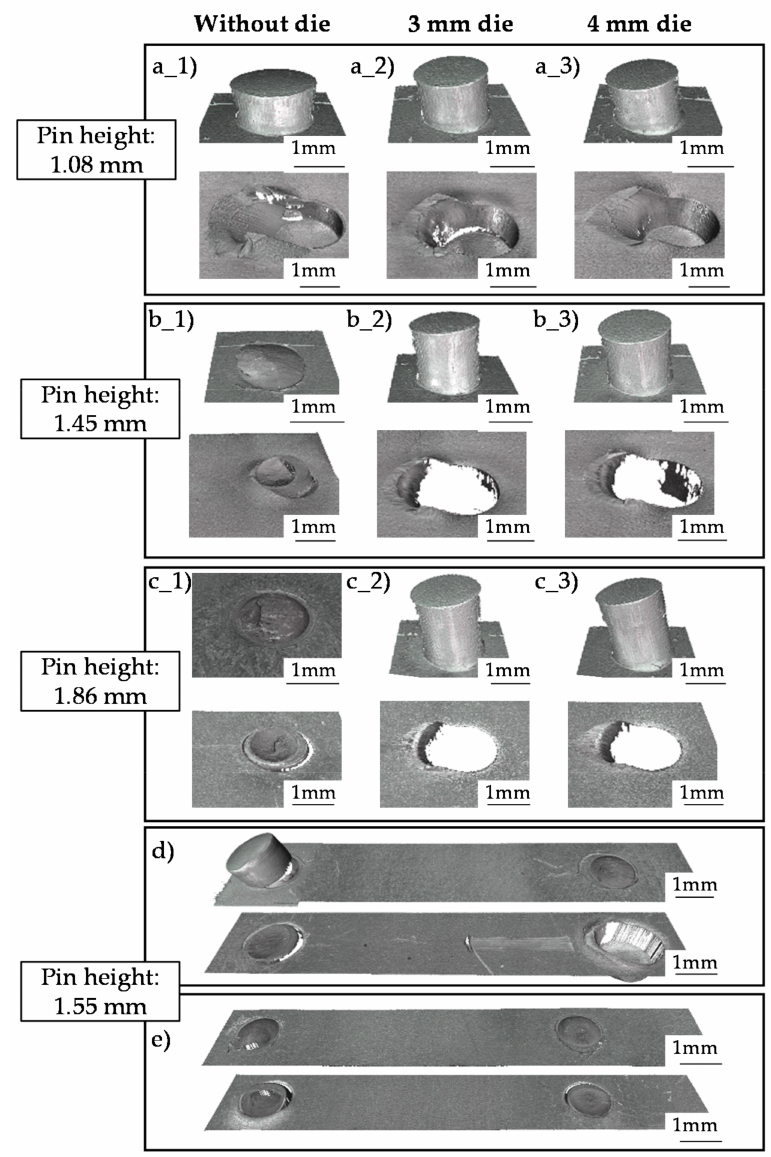
Figure 12. Damage patterns of the examined joints with steel sheet containing the pin structure at the top and corresponding aluminium sheet at the bottom. ( a_1 ) 1.08 mm pin joined without die, ( a_2 ) 1.08 mm pin joined with 3 mm die, ( a_3 ) 1.08 mm pin joined with 4 mm die, ( b_1 ) 1.45 mm pin joined without die, ( b_2 ) 1.45 mm pin joined with 3 mm die, ( b_3 ) 1.45 mm pin joined with 4 mm die, ( c_1 ) 1.86 mm pin joined without die, ( c_2 ) 1.86 mm pin joined with 3 mm die, ( c_3 ) 1.86 mm pin joined with 4 mm die, ( d ) 1.55 mm longitudinal multi pins and ( e ) 1.55 mm transverse multi